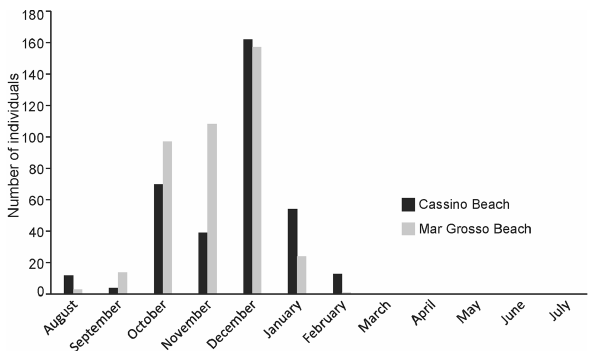
Figure 2. Number of Oncopterus darwinii juveniles caught at Cassino (black bars) and Mar Grosso (grey bars) between August 2009